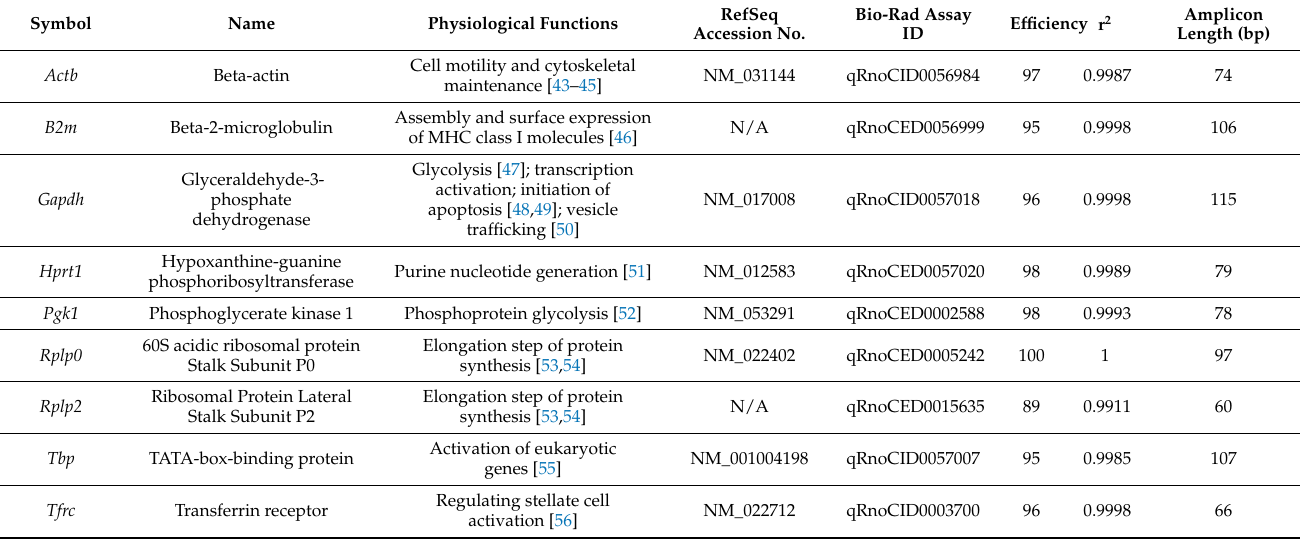
Table 1. Summary of the nine HKGs evaluated in this